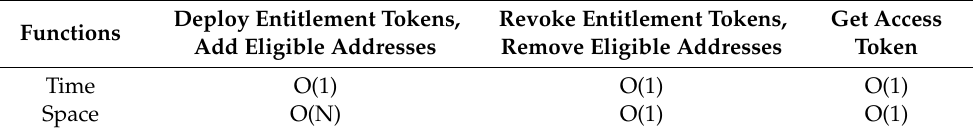
Table 4. Time and space complexity for smart contract functions using mapping data structure.